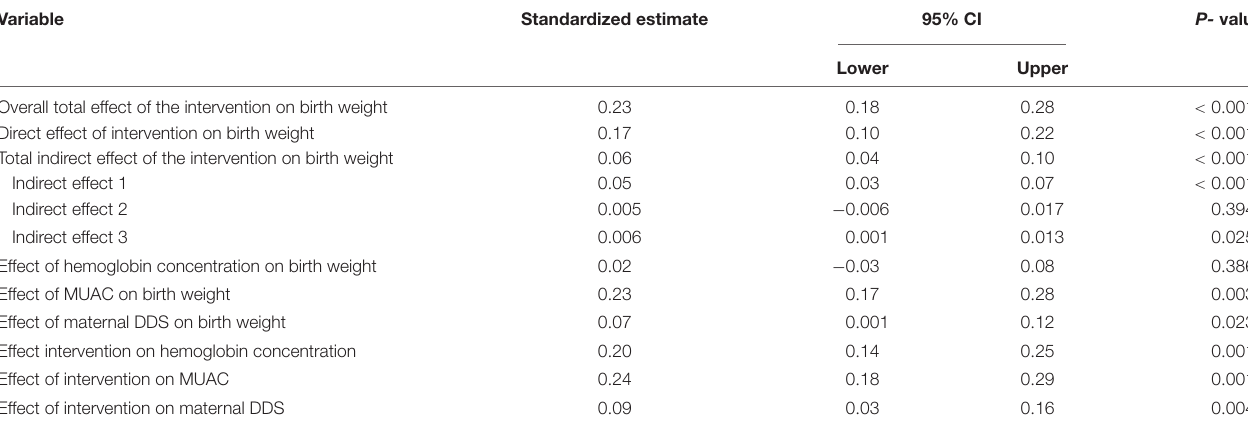
TABLE 5 | Pathway and mediation analysis for the direct and indirect effects of the intervention on birth weight.